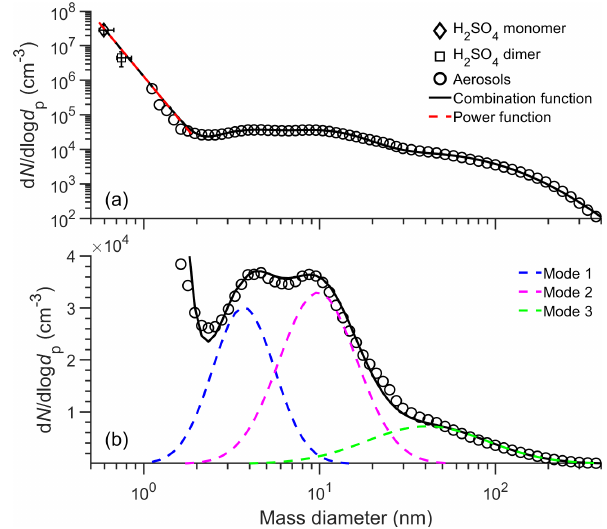
Figure 3. The median daytime NPF type number size distributions from H 2 SO 4 monomer to larger aerosols and the fitted size distri- butions shown in (a) logarithm scale and (b) linear scale of y axis. The x axis error bars of H 2 SO 4 monomers and dimers indicate the variation range of estimated H 2 SO 4 monomers and dimers diam- eters by assuming the bulk density to be 1000–1800kgm 3 . The y axis error bars of H 2 SO 4 monomers and dimers indicate the 25th– 75th range of concentrations. The black and red lines indicate the fitted size distribution in the whole size range and in sub-3nm size range, respectively. The blue, magenta, and green lines present the fitted mode 1, mode 2, and mode 3, respectively. The diamonds, squares, and circles represent the distribution function (d N /dlog d p ) of H 2 SO 4 monomers, dimers, and aerosols,